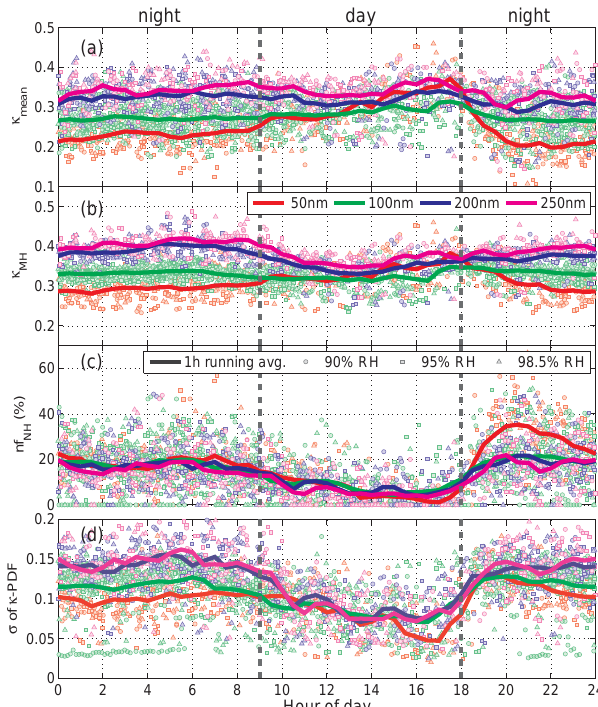
Fig. 5. Diurnal variations of aerosol hygroscopic properties; (a) mean κ of all groups; (b) κ of more-hygroscopic group; (c) the number fraction of nearly-hydrophobic group; (d) the spread of κ -